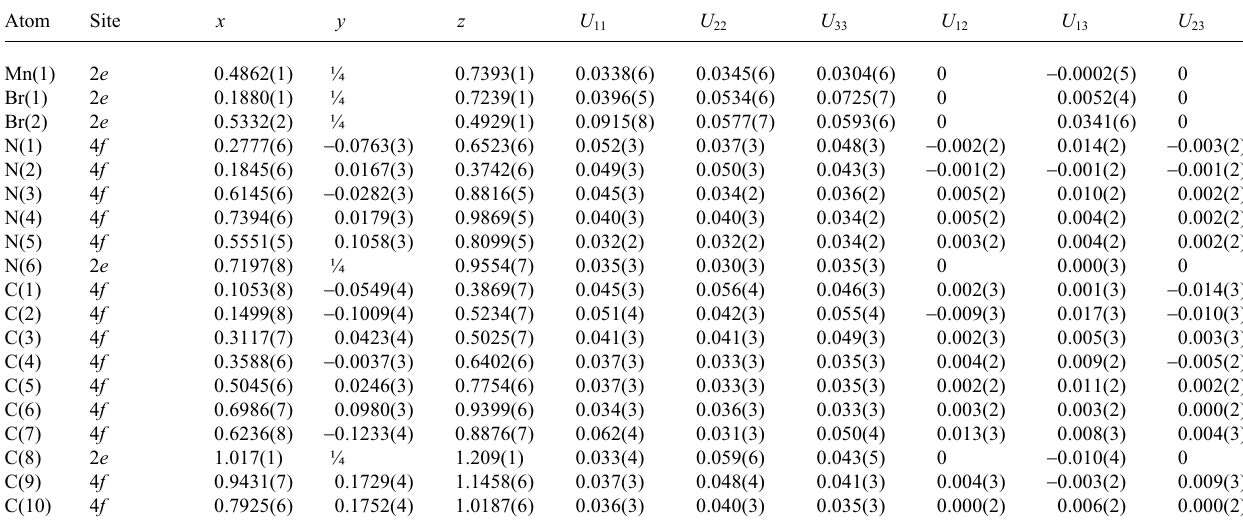
Table 3. Atomic coordinates and displacement parameters (in Å 2 )